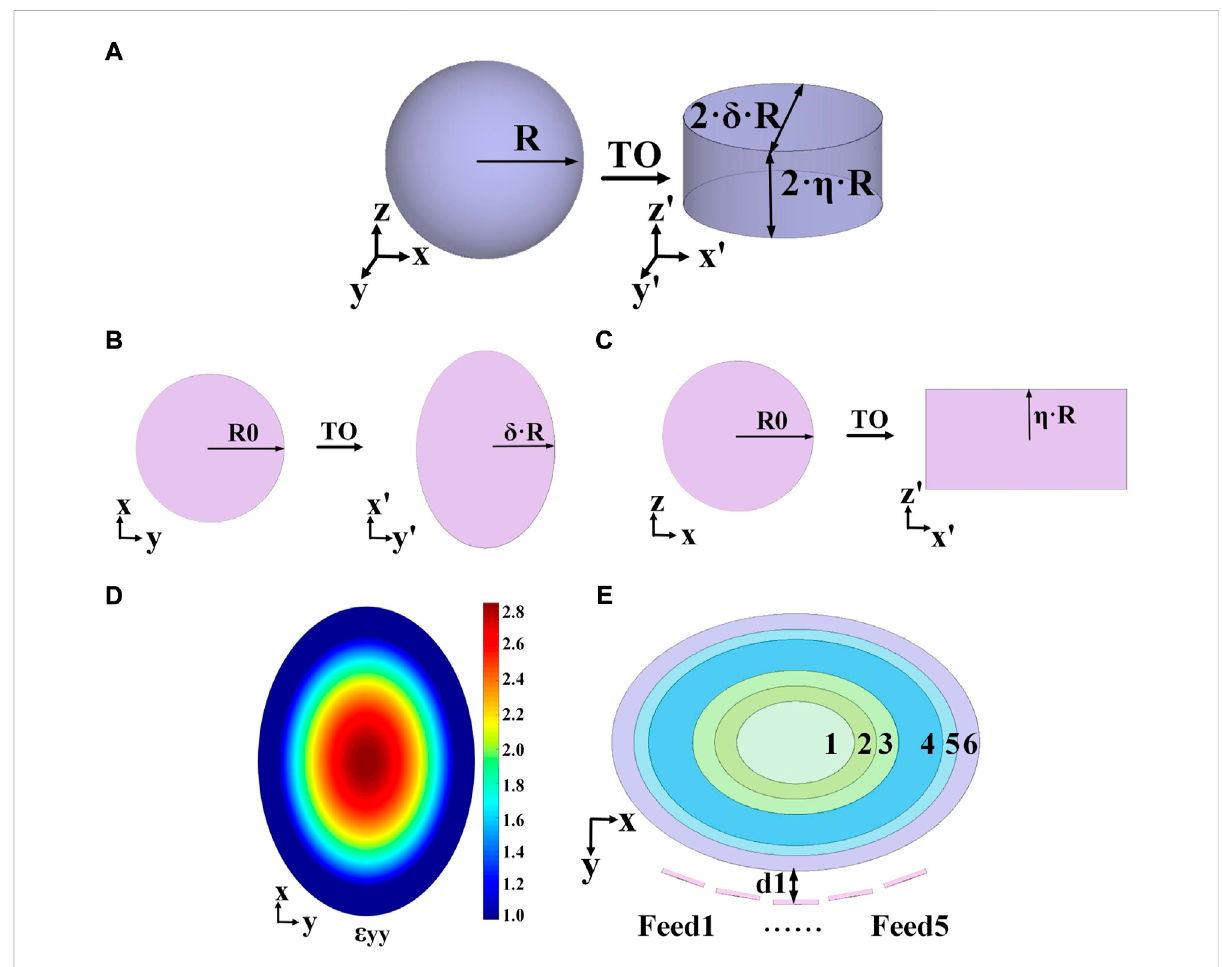
FIGURE 1 Transformation schematic of the Luneburg lens. (A) The proposed approach of transformation. (B) Compression of the y-coordinate. (C) Compression of the z-coordinate. (D) Distribution of the ε yy component. (E) Shells and feeds.